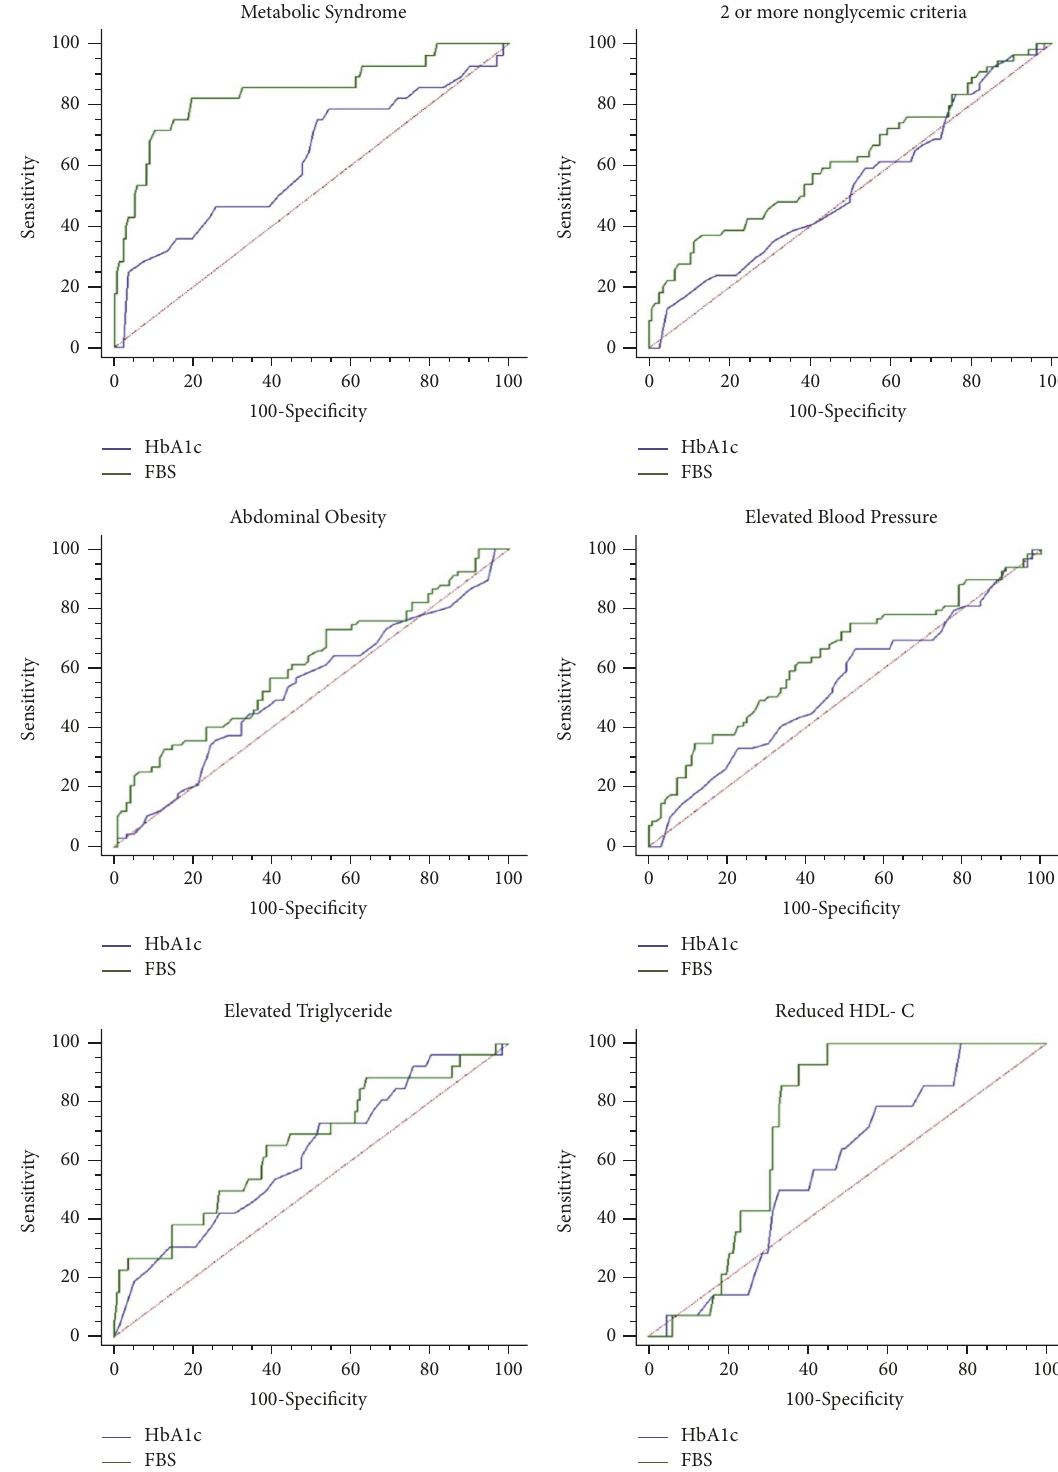
Figure 1: ROC curves for MetS. Compared are the relative abilities of HbA1c and FPG to identify respondents with MetS and its